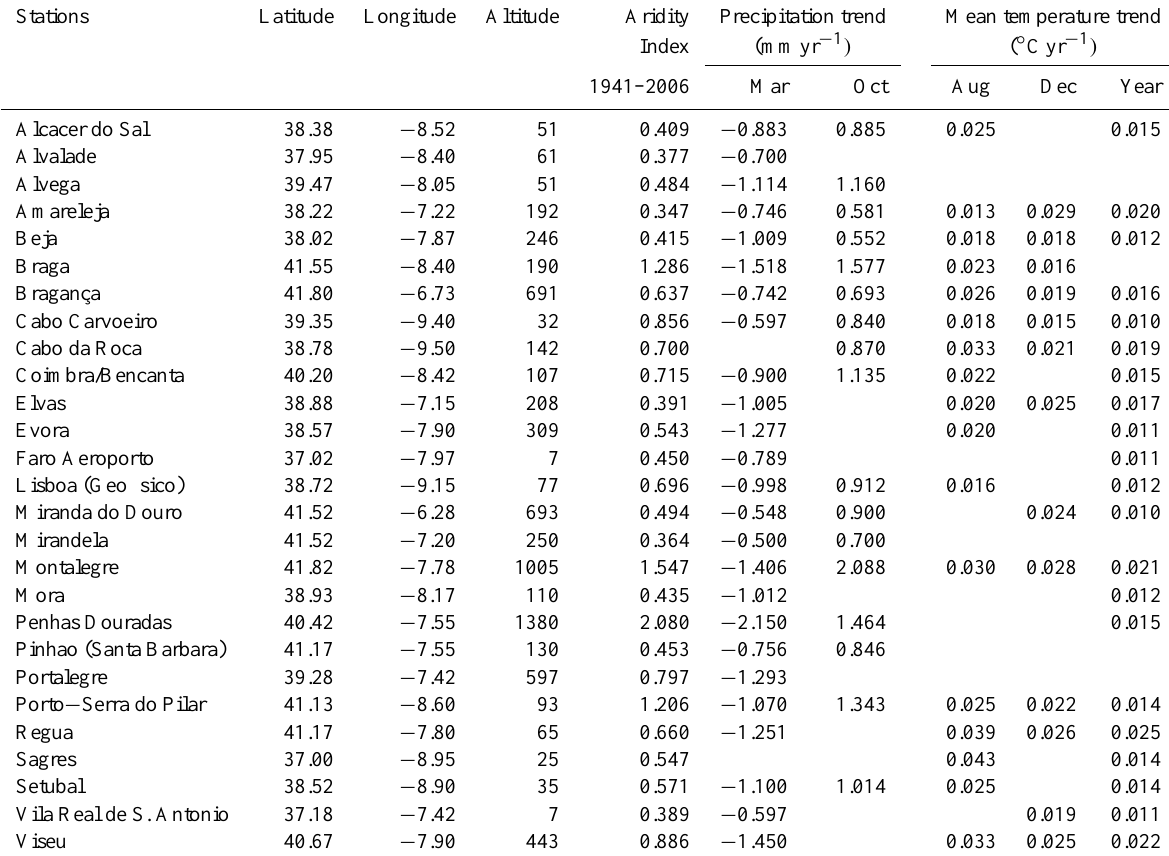
Table 1. Coordinates and altitude of the weather stations used in this study, respective aridity index and precipitation and temperature trends.